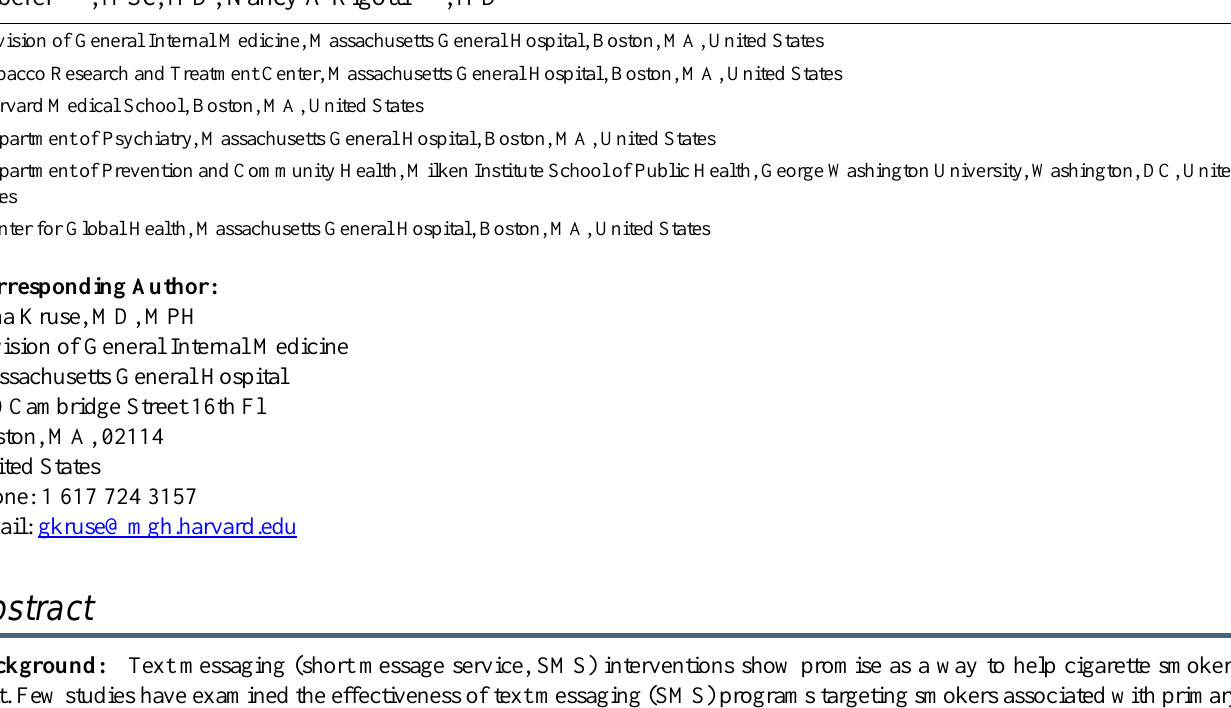
text messaging; smoking cessation; primary